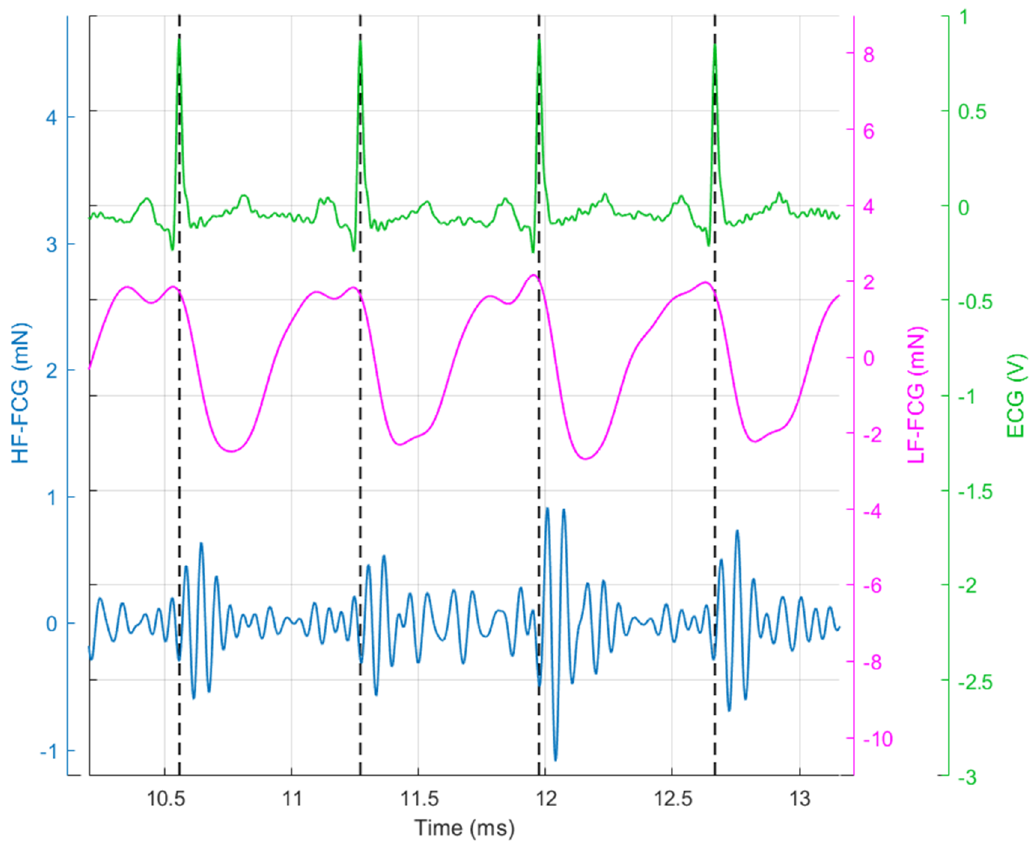
Figure 4. Subject #2 dataset: ECG is shown in green and scaled in mV, low-frequency (LF)-FCG is shown in purple and scaled in mN and high-frequency (HF)-FCG is shown in blue and scaled in mN.